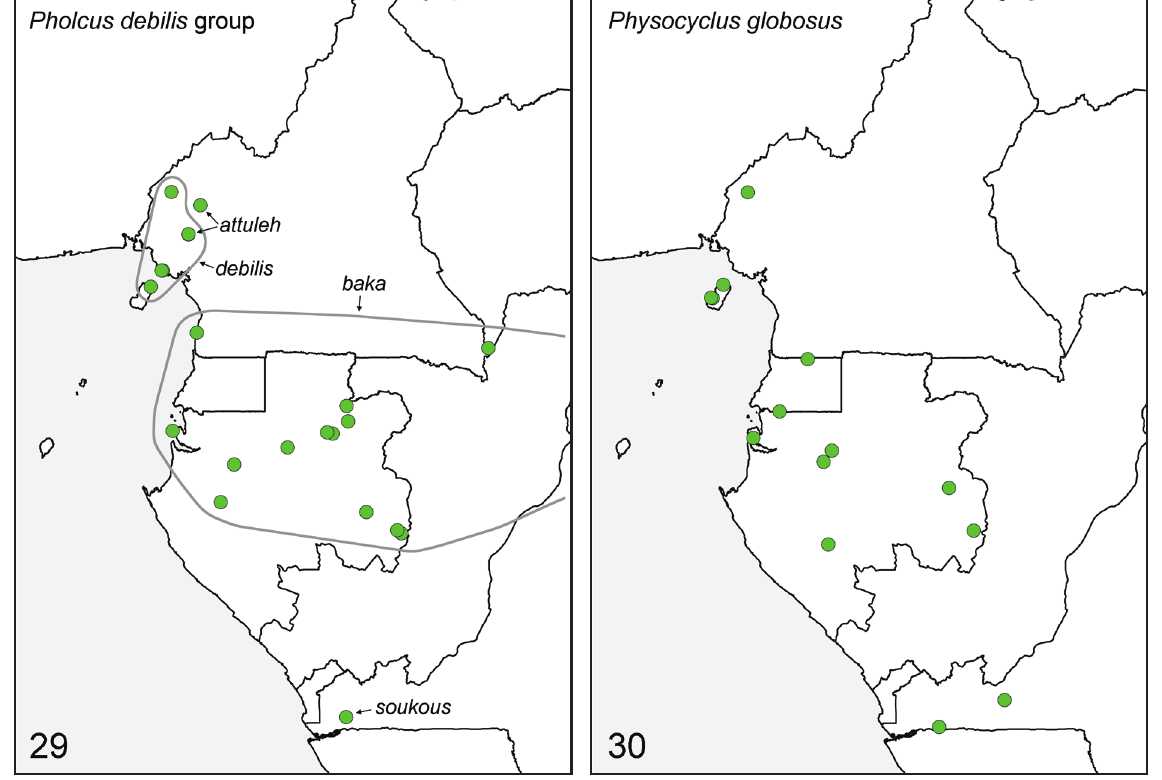
Figs 29-30. Known distributions of the debilis species group ( sensu Huber 2011b) of Pholcus Walckenaer, 1805 and of Physocyclus globosus (Taczanowski, 1874) in Central